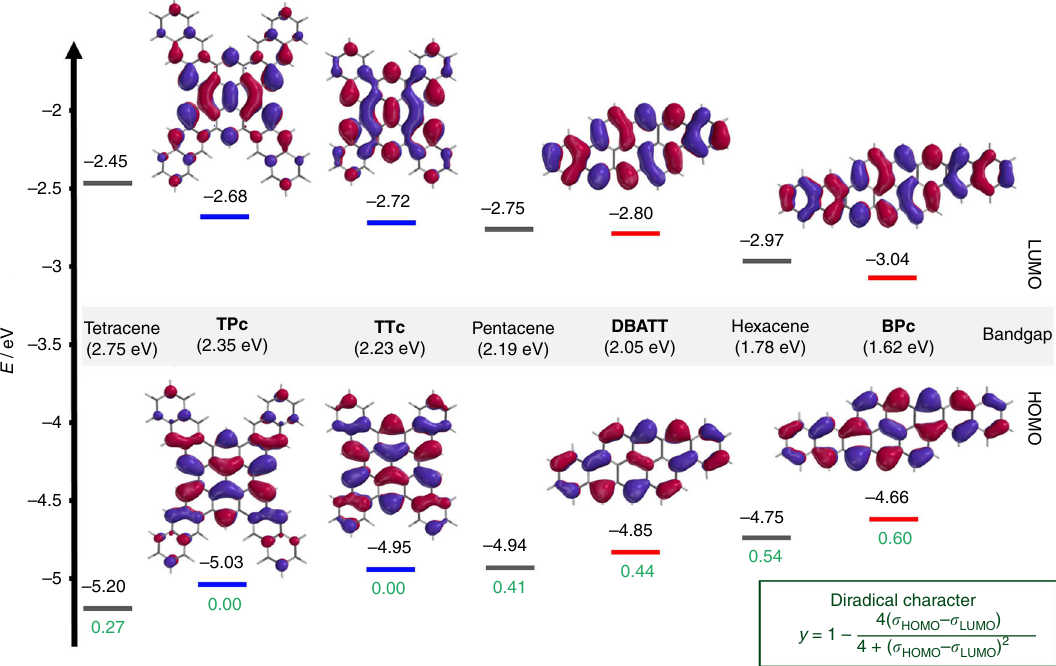
Fig. 6 Computational analysis of the zzNGs. Calculated HOMO-LUMO energies and frontier orbitals (isoval: 0.02 a.u.) at the DFT B3LYP 6 – 311 G + (d,p) level of theory; Theoretical diradical character y (green digits) was obtained from the broken symmetry calculation at the UHF 6 – 31 + G(d,p) level of